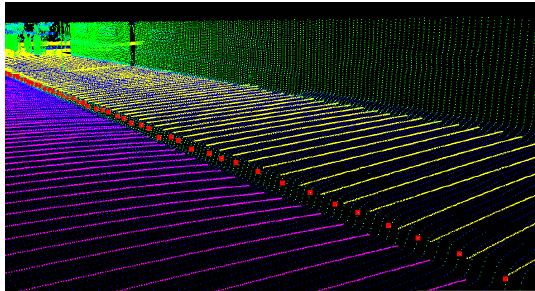
Figure 12: An example of surface modeling on a curb area.